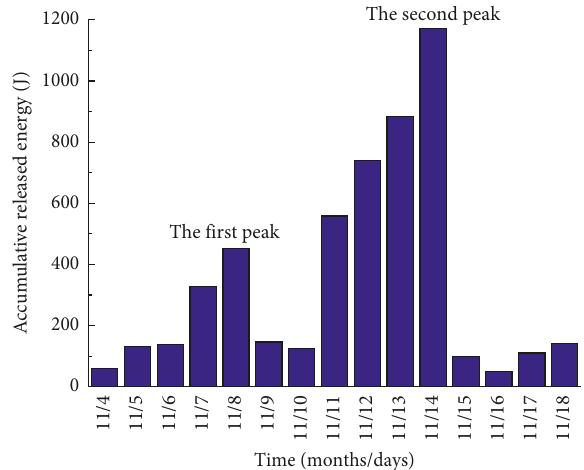
Figure 7: Evolution law of the microseismic energy with time during the large-scale deformation and failure process of soft rock.